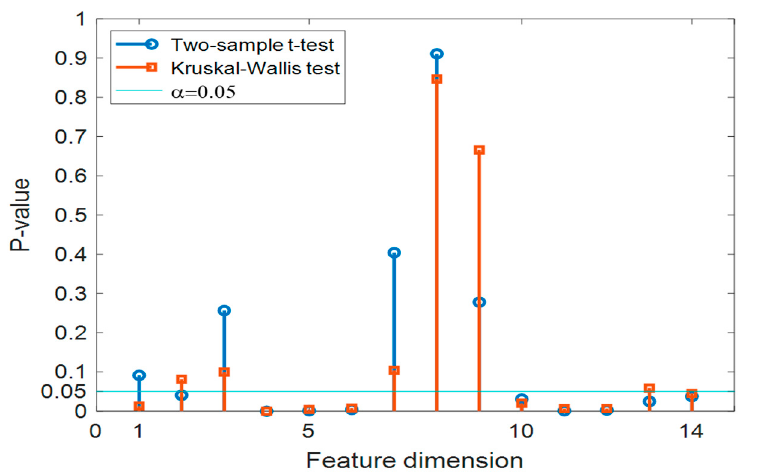
Table 3. The p -values and their Holm–Bonferroni corrections for both significance tests. Only the bands (dimensions) with α < 0.05 are listed.